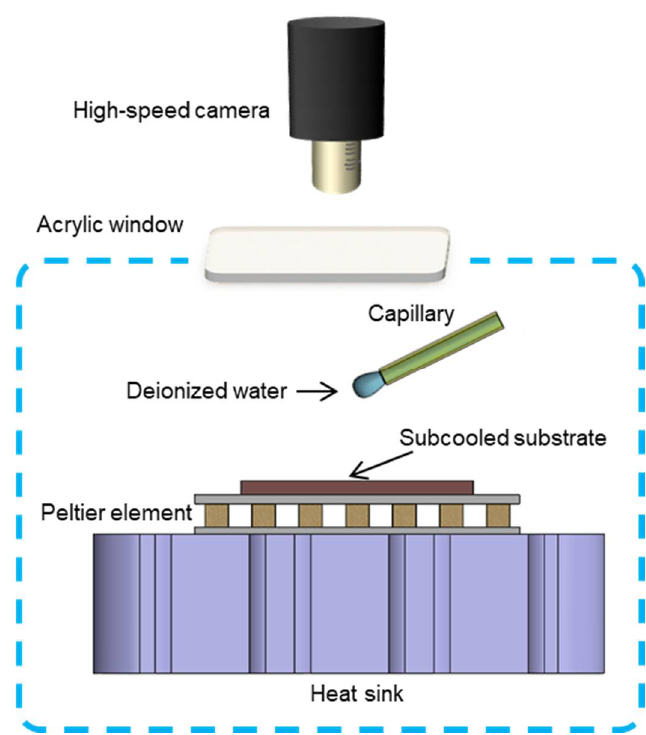
Figure 1. Schematic of the experimental